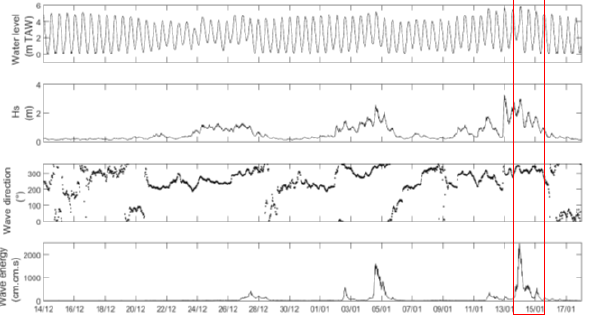
Figure 3. Time series of water level, onshore significant wave height (Hs), wave direction and wave energy between the LiDAR surveys. The red box corresponds to the Dieter storm event. The most energetic period of the storm took place between 12am on 14 th January and 2am on 15 th January during which the maximum water level reached 5.89 m TAW on 14 th January at midnight with a peak significant wave height (Hs, the highest 33% of the waves) of 2.87 m and wave energy of 2150